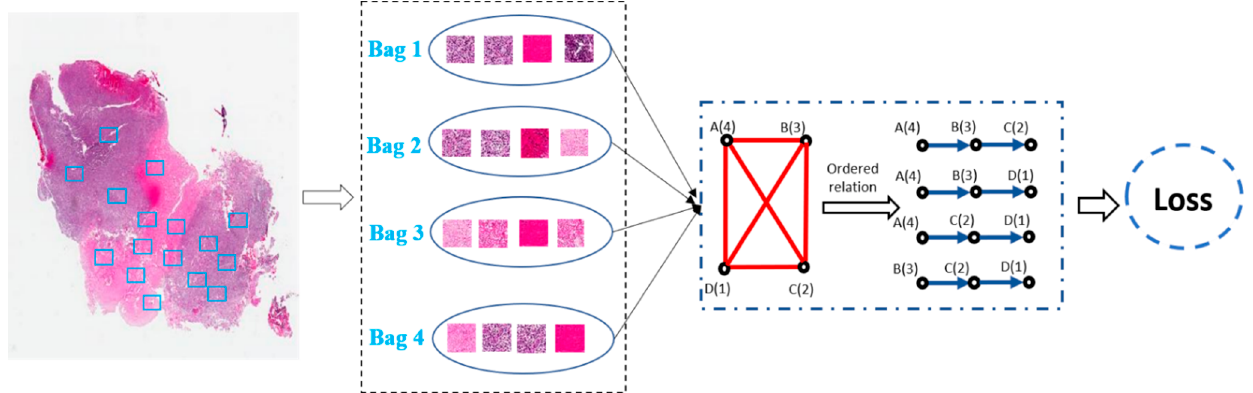
Figure 8. Weakly-supervised deep ordinal Cox model (BDOCOX) for survival prediction from WSI.